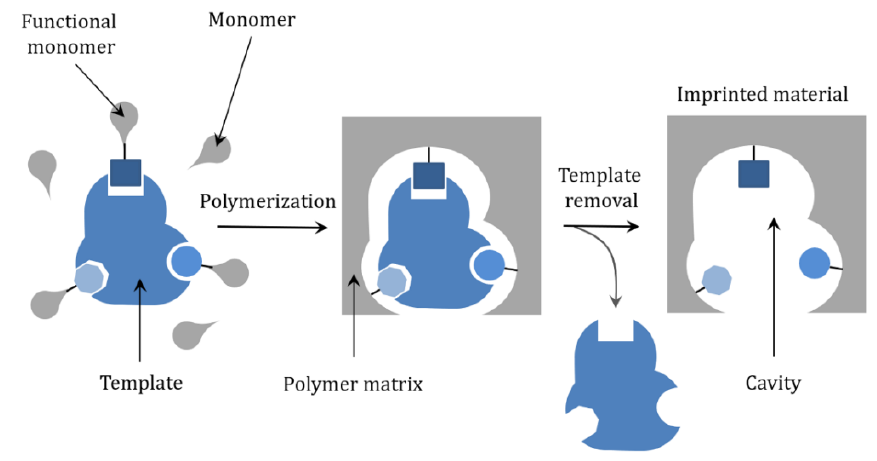
Figure 3. Preparation of molecularly imprinted materials.